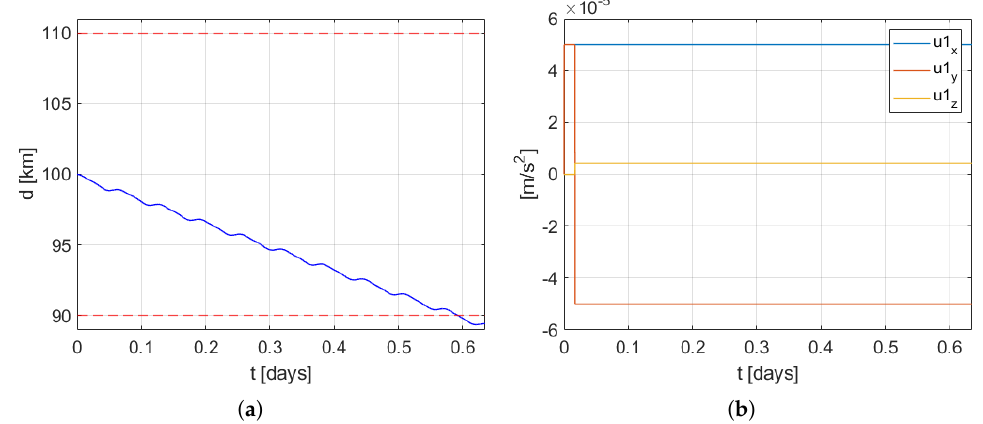
Figure 6. MPC formation control using HCW model with large command bounds. ( a ) Inter- satellite distance. ( b ) Commands requested by MPC.